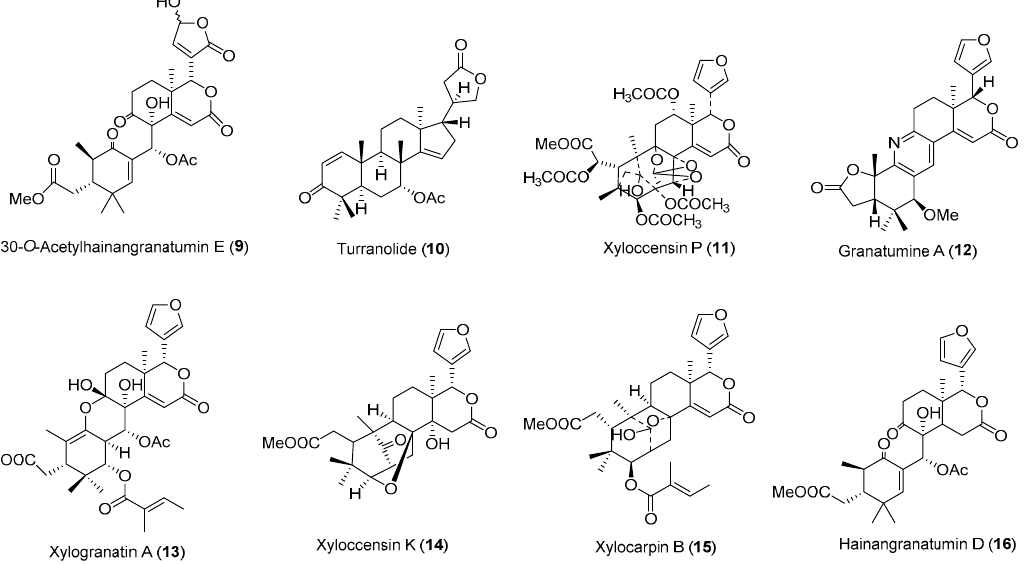
Figure 6. Eight Natural Limonoid Compounds Studied in This Work.